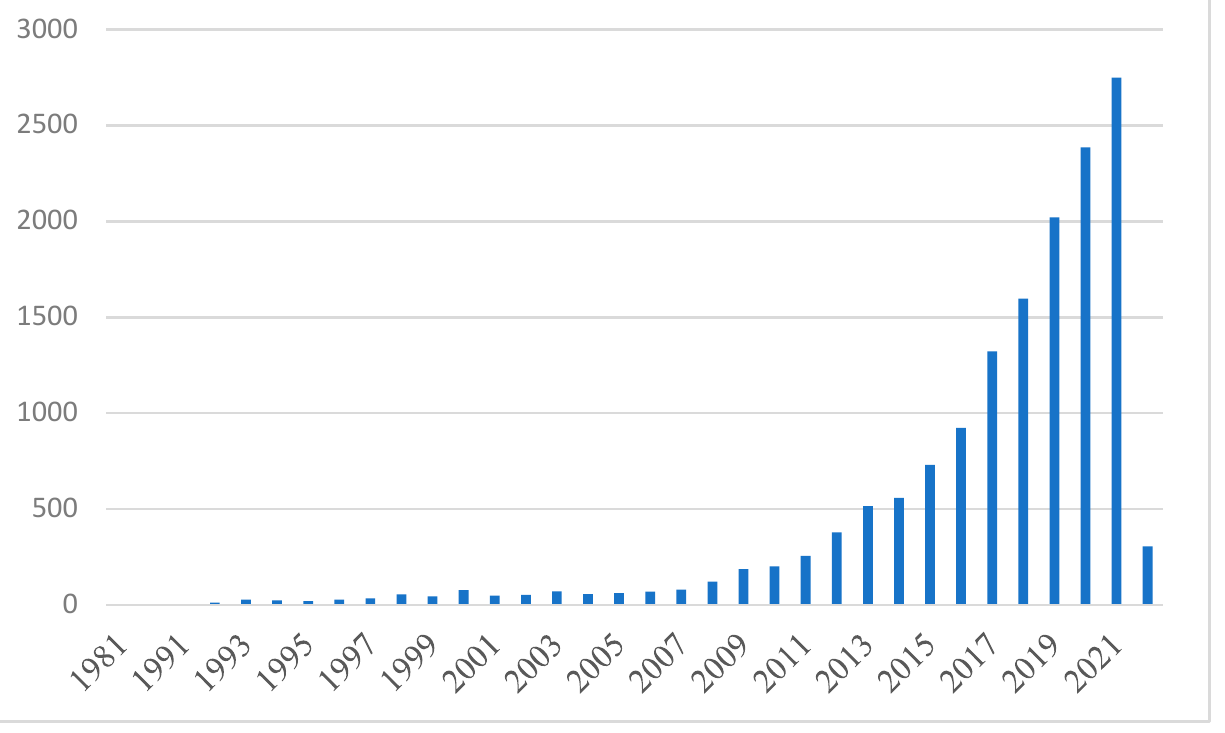
Figure 1. Dynamics on publications regarding renewable energy transition. Source: Authors’ pro- jection.